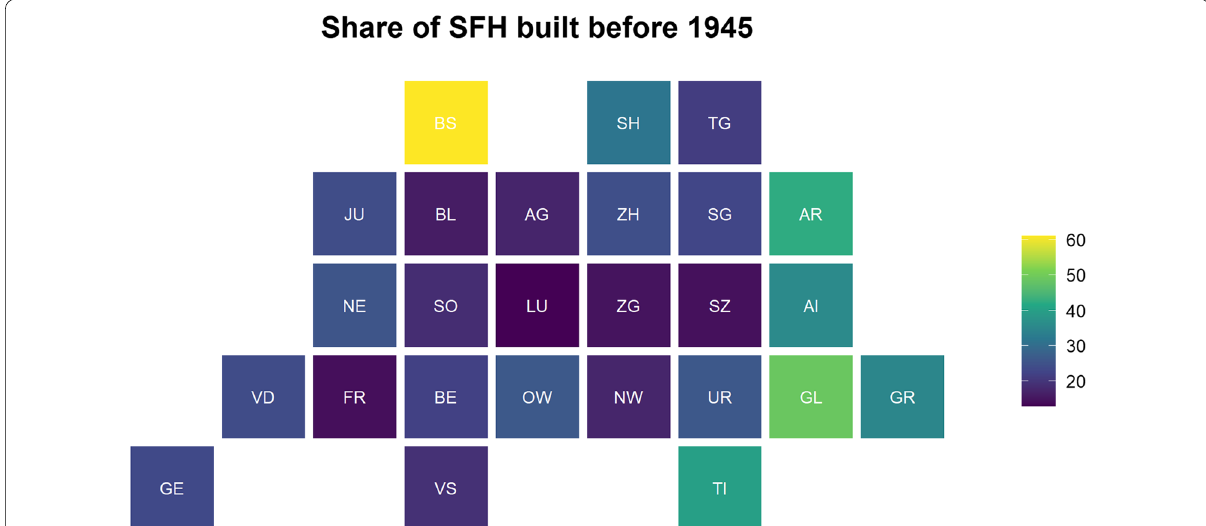
Fig. 1 Share of SFHs built before 1945 by canton, as of 2019. The respective shares are given in percent. Data : Federal Statistical Office FSO